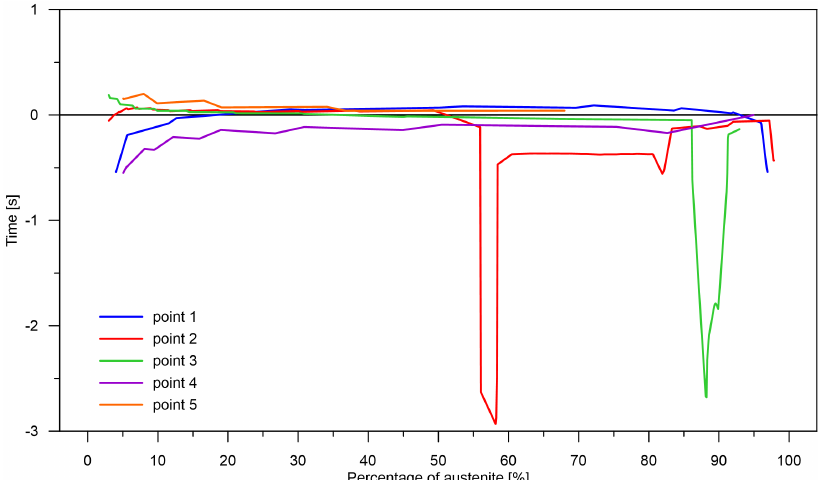
Figure 14. Time to achieve the required level of transformation for case No. 3 (difference between analytical and RNN model—control rates).